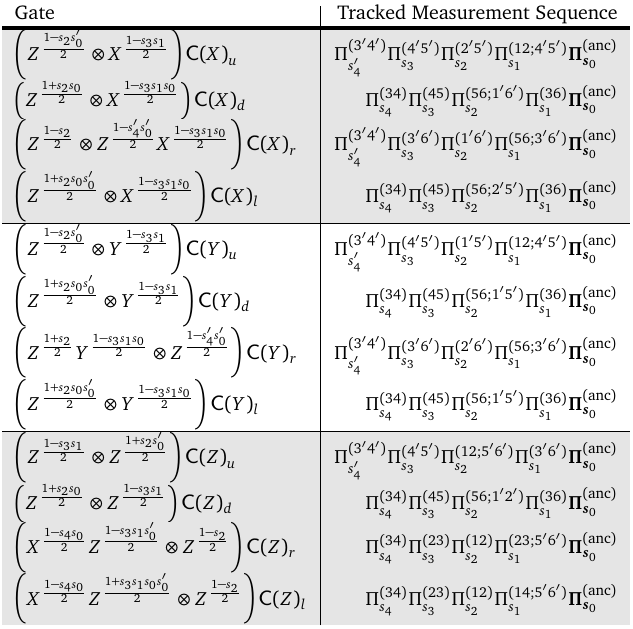
Table 18: Pauli gate corrections tracked for the corresponding controlled-Pauli gates implemented using Majorana-Pauli tracking methods. The implicit action 1 − s (cid:48) ns (cid:48) 0 1 − sns 0 Π ( 34 ) ⊗ X Π ( 3 (cid:48) 4 (cid:48) ) on the two ancillary qubits is X for sequences of length n . 2 2 s 0 s (cid:48) 0 (When there is not a final projector for one of the ancillary pairs, it is equivalent to there being a projector for that ancillary pair onto its initial projection channel, = s = s (cid:48) e.g. s or s (cid:48) n 0 n 0